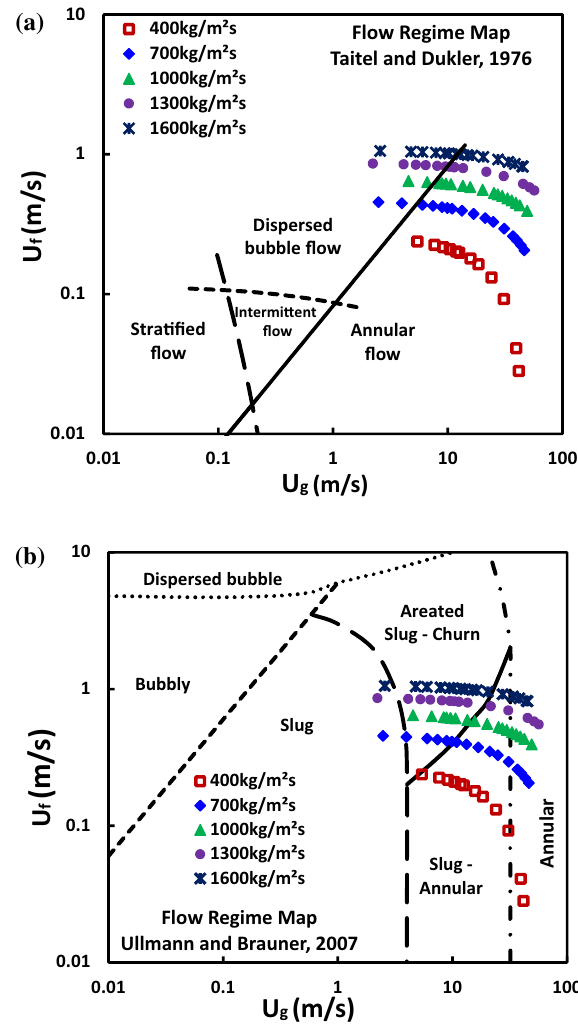
Figure 12. ( a ) Taitel–Dukler 32 flow regime map for SiNW data (at different mass fluxes of HFE-7100); ( b ) Ullmann–Brauner 33 flow regime map for SiNW data (at different mass fluxes of